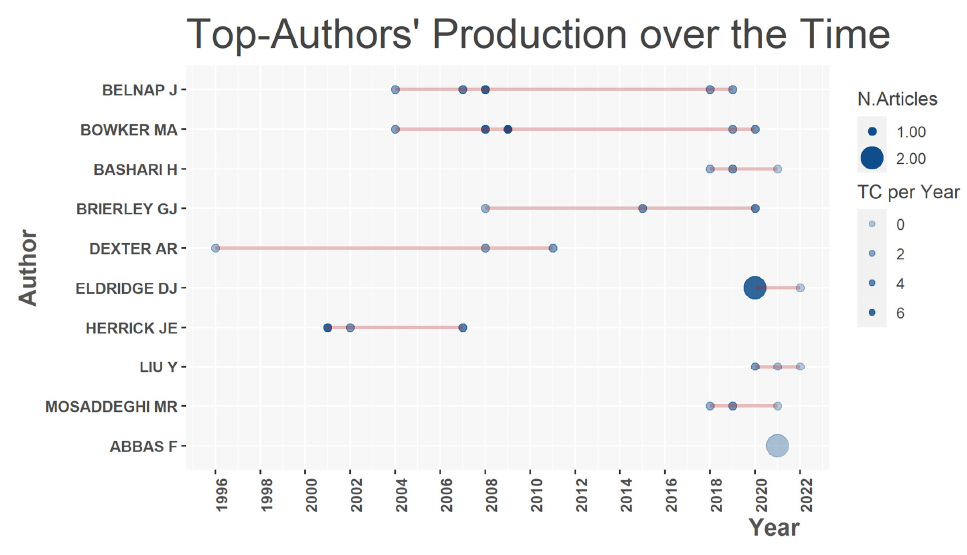
Figure 3. Production of top authors over time. TC: Average citations per year. Table 3. Total and local citation analysis of the 10 most relevant documents in the present dataset. TC: Total number of citations, LC: Local number of